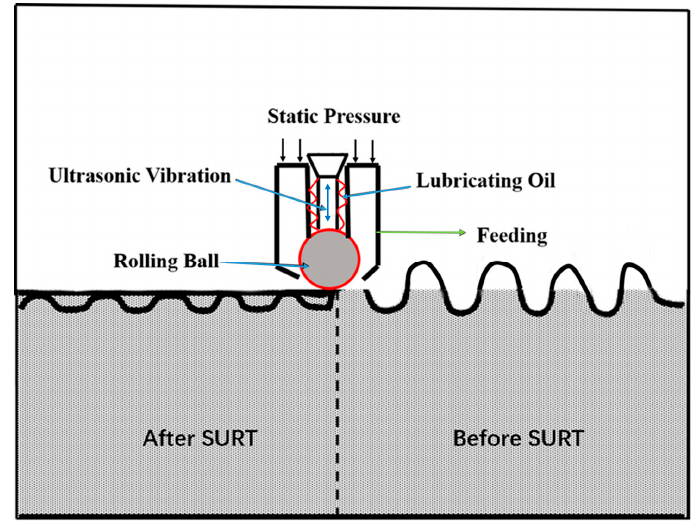
Figure 2. The schematic diagram of surface ultrasonic rolling machine [14].